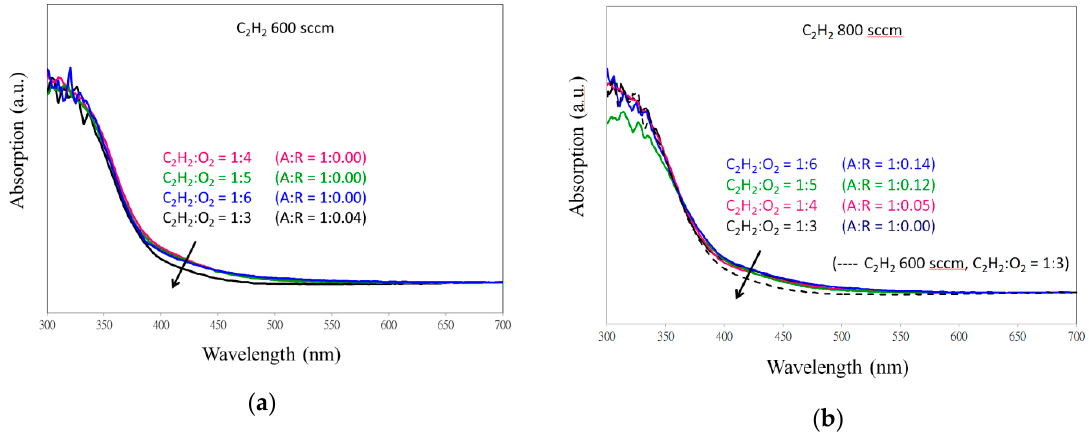
Figure 4. UV–visible absorption spectra of TiO 2 powders produced by the FFCVC method with ( a ) C 2 H 2 600 sccm and with ( b ) C 2 H 2 800 sccm. The dashed line provided in ( b ) is the spectrum for the sample with C 2 H 2 600 sccm, C 2 H 2 /O 2 = 1:3, for comparison purposes. The anatase-to-rutile ratio (A:R) is also indicated.